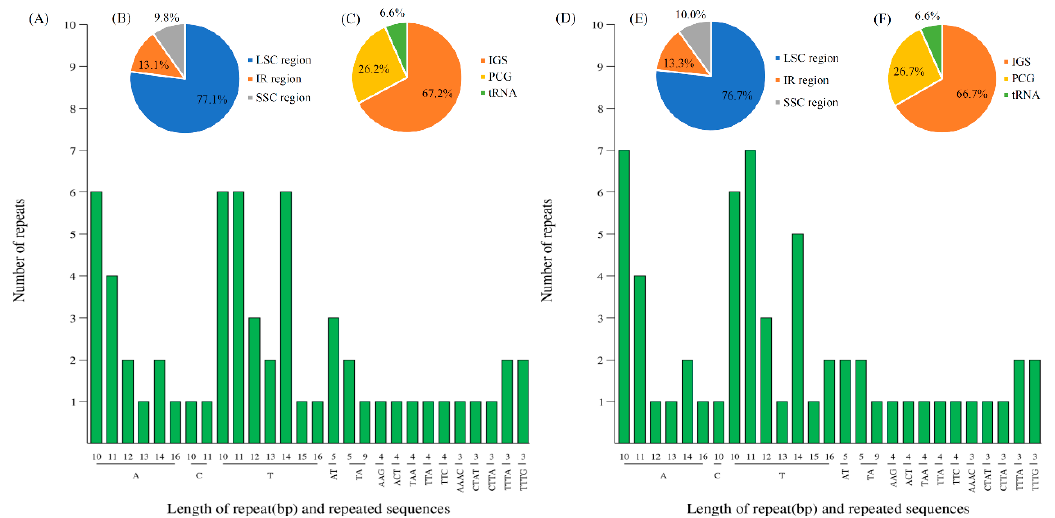
Figure 4. Simple-sequence repeat (SSR) types, distribution and presence in PMA and PIX. ( A ), the types of SSR motifs detected in the PMA cp genome; ( B , C ), the frequency of SSRs in different regions (IRa, IRb, LSC, and SSC), and in IGS, PCG and tRNA, respectively; ( D ), the types of SSR motifs detected in the PIX cp genome; ( E , F ), the frequency of SSRs in different regions (IRa, IRb, LSC, and SSC), and in IGS, PCG and tRNA, respectively.